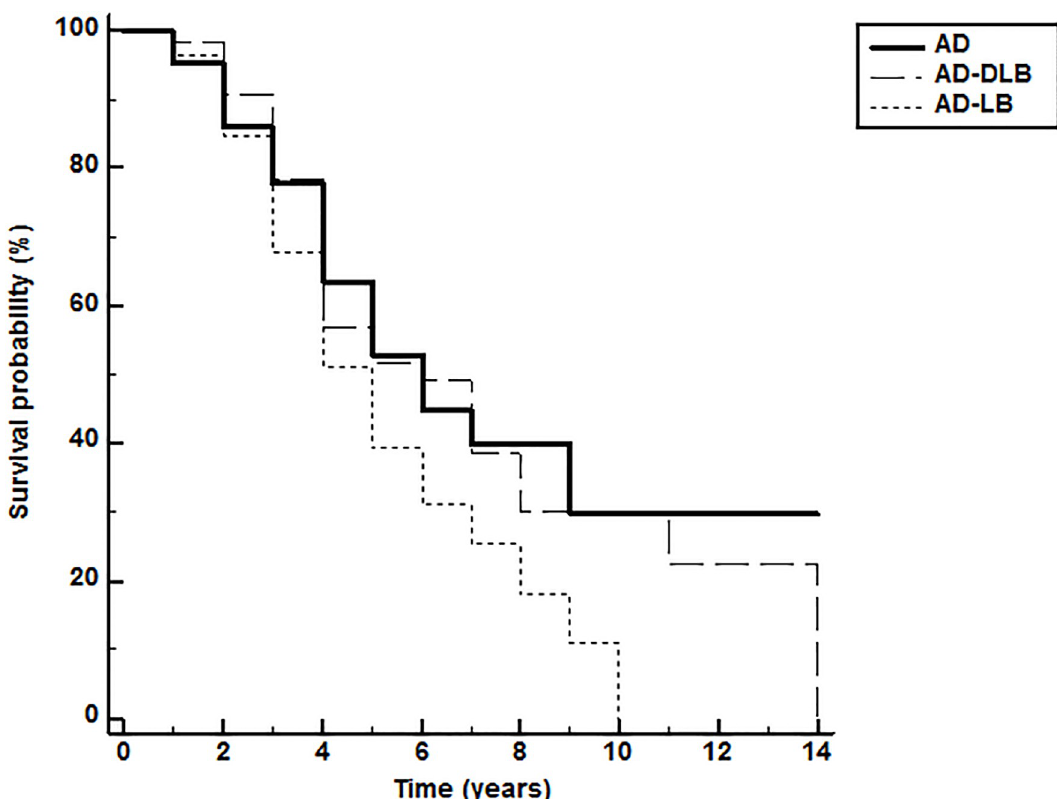
Fig 2. Kaplan-Meier curve for time to 10-point MMSE decline. The log-rank test for the survival curve differences was statistically significant (p = 0.03; Figure 2); the AD-LB had a significantly faster time to a 10-point MMSE decline relative to the AD group (HR = 1.51; 95% CI: 1.04, 2.19). All other groupwise comparisons were not statistically